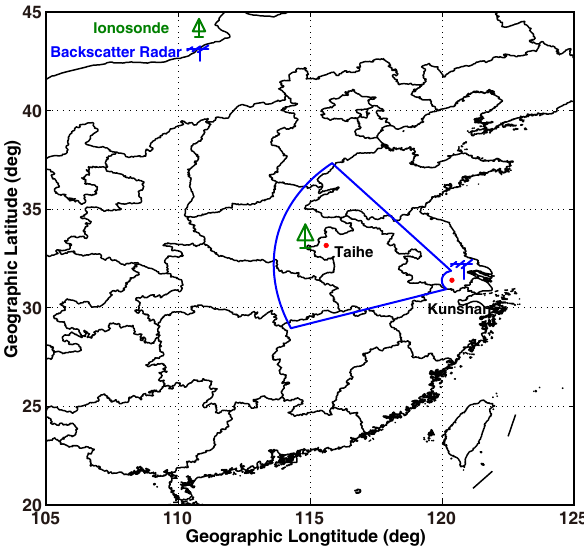
Fig. 4. Map showing the location of the WIOBSS at Kunshan and the location of the vertical ionosonde at Taihe for the experiment on 24 May